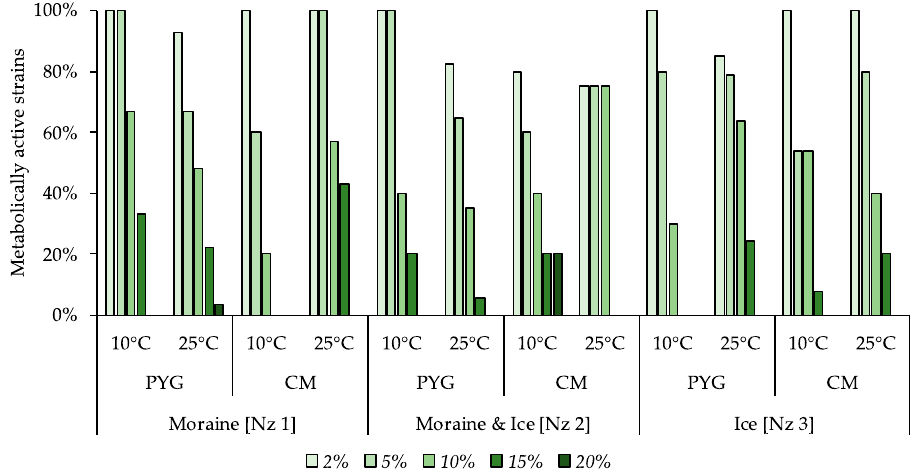
Figure 8. Isolated strains’ resistance to the presence of sodium chloride in nutrient medium. Vertical axis: proportion of the strains in the culturable community able to reproduce in the considered conditions. Horizontal axis: the tested communities. Temperature and medium abbreviations indicate the isolation conditions. PYG and CM—peptone yeast glucose and modified Czapek media, respectively.